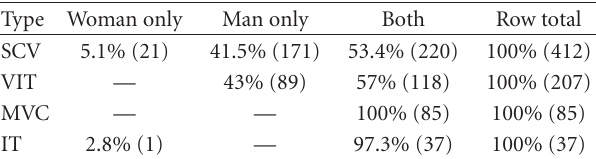
Table 2: Mutuality of violence by relationship category (intimate terrorism and situational couple violence only n =